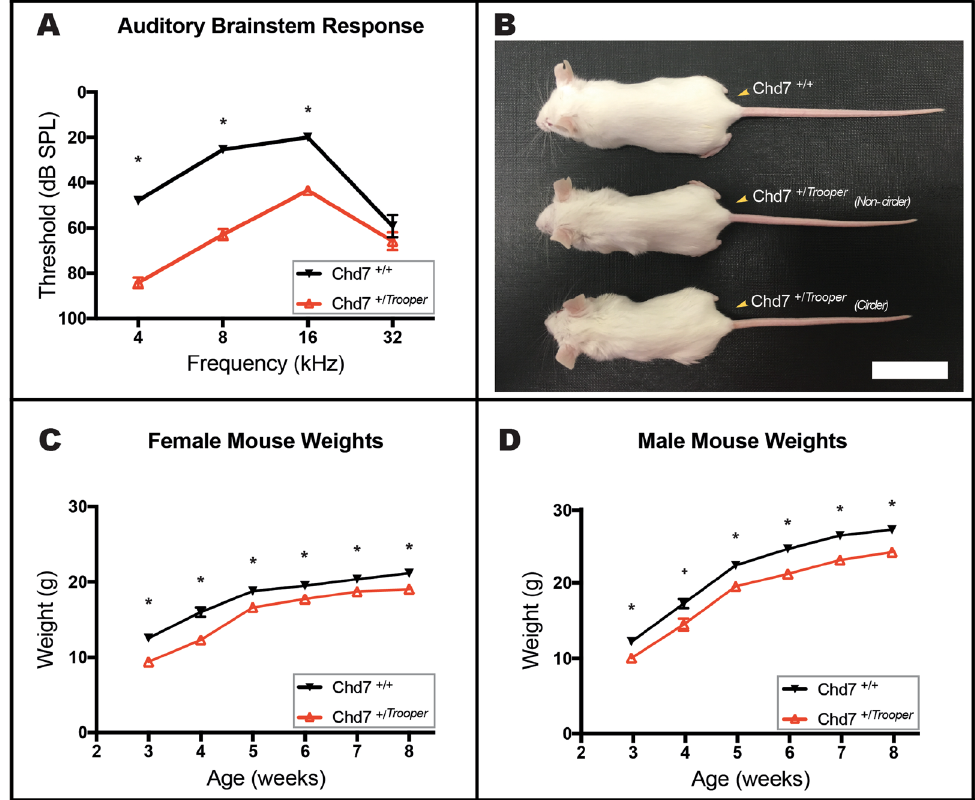
Figure 4. Trooper mice are hearing impaired and have growth deficiencies. ( A ) Average ABR thresholds of Chd7 + /Trooper (n = 12) and Chd7 + / + (n = 12) mice. Chd7 + /Trooper thresholds were significantly elevated at 4,8 and 16 kHz in comparison to Chd7 + / + controls. * p < 0.001 based on t- tests performed with the Holm-Sidak correction for multiple comparisons. Error Bars = SEM. ( B ) Photograph of female Chd7 + / Trooper and Chd7 + / + littermates (at 50 days of age) illustrating the reduced size and length of Chd7 + / Trooper mice. Scale Bar = 3 cm. ( C,D ) Average weights of male and female Chd7 + / + (n = 19 female and 20 male) and Chd7 + /Trooper (n = 26 female and 21 male) mice, from 3–8 weeks of